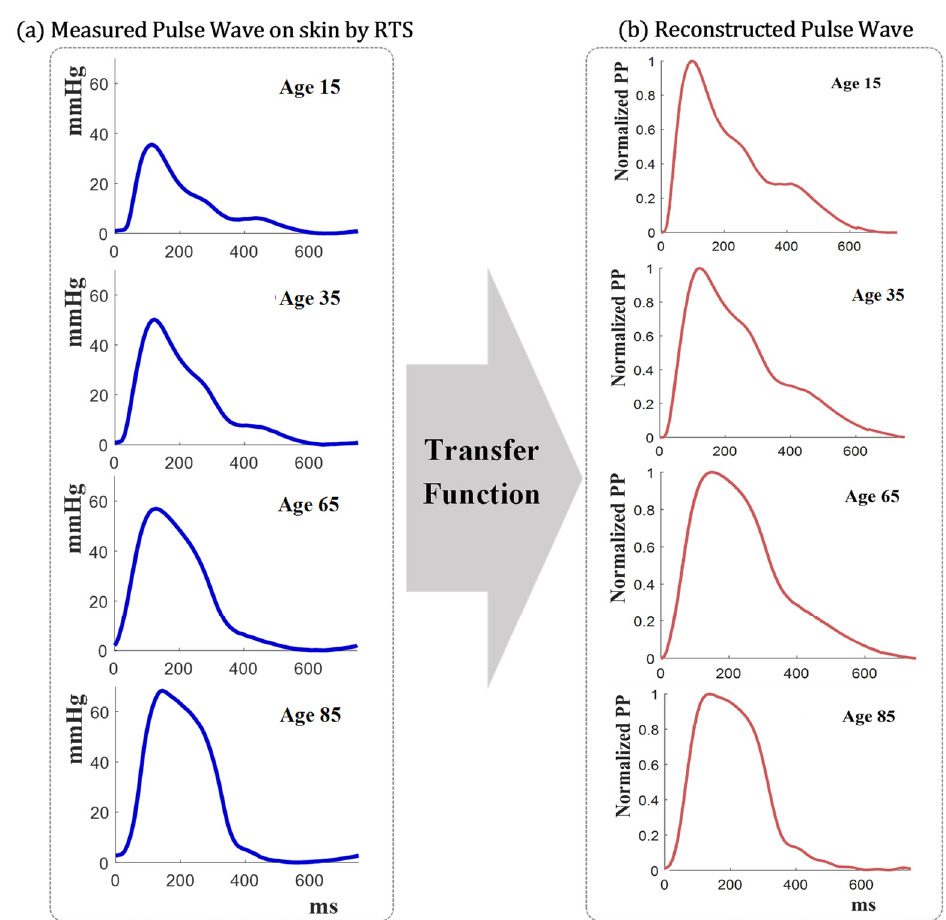
Figure 9. Reconstruction of age-related intravascular pressure waveforms: ( a ) Pulse pressure measured on the skin by the RTS, ( b ) reconstructed intravascular pulse pressure waveforms by the skin-vessel transfer function.